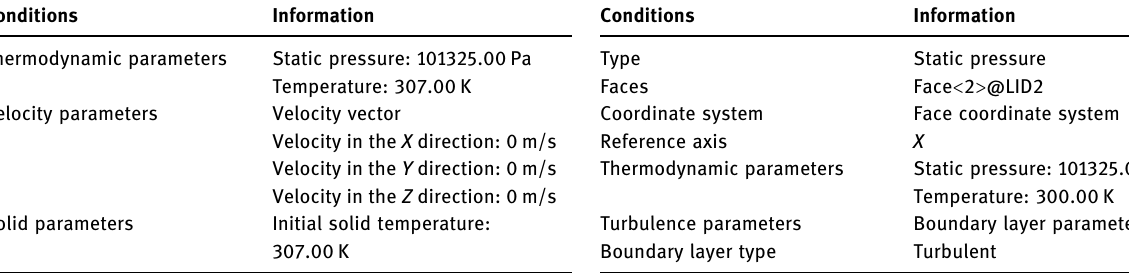
Table 2: Ambient conditions Conditions